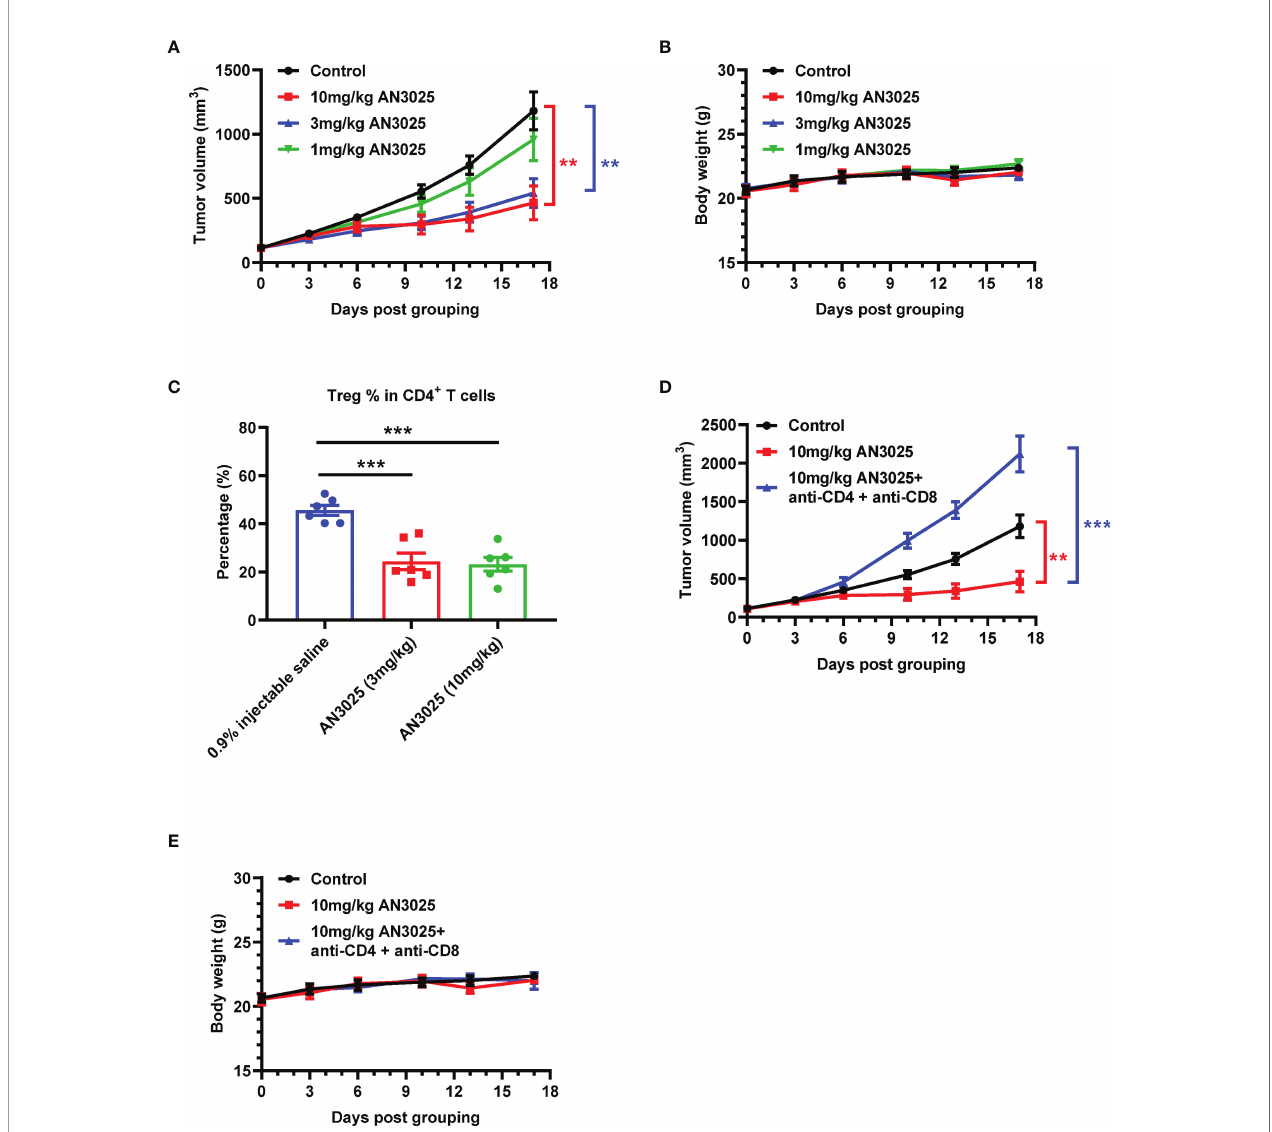
FIGURE 3 | AN3025 signi fi cantly inhibits MC38 tumor growth as a monotherapy in hTNFR2 mouse model. (A – E) Murine colon cancer MC38 cells (5E5) were implanted subcutaneously into homozygous TNFR2 humanized mice (female). Mice were grouped when tumor volume reached approximately 100 mm 3 . (A, B) MC38 tumor bearing TNFR2 humanized mice were treated with AN3025 at the dosage of 10mg/kg, 3mg/kg or 1mg/kg every 4 days intraperitoneally for 5 doses in total. (A) Tumor volume measurement during the treatment (n=8 each group). (B) Body weight record during the treatment (n=8 each group). (C) MC38 tumor bearing TNFR2 humanized mice were treated with AN3025 at the dosage of 10mg/kg, 3mg/kg every 3 days intraperitoneally for 3 doses in total. Tregs (CD45 + CD3 + CD4 + Foxp3 + ) frequency in total CD4 + T cells in the MC38 tumors was quanti fi ed by fl ow cytometry (n=6 each group). (D, E) MC38 tumor bearing TNFR2 humanized mice were treated intraperitoneally with 10mg/kg AN3025 alone or combination of 10mg/kg AN3025, 0.3mg/mouse anti-mouse CD4 depletion antibody and 0.3mg/mouse anti-mouse CD8 depletion antibody every 4 days for 5 doses in total. (D) Tumor volume measurement during the treatment (n=8 each group). (E) Body weight record during the treatment (n=8 each group). Values were expressed as Mean ± SEM. **P < 0.01; ***P <